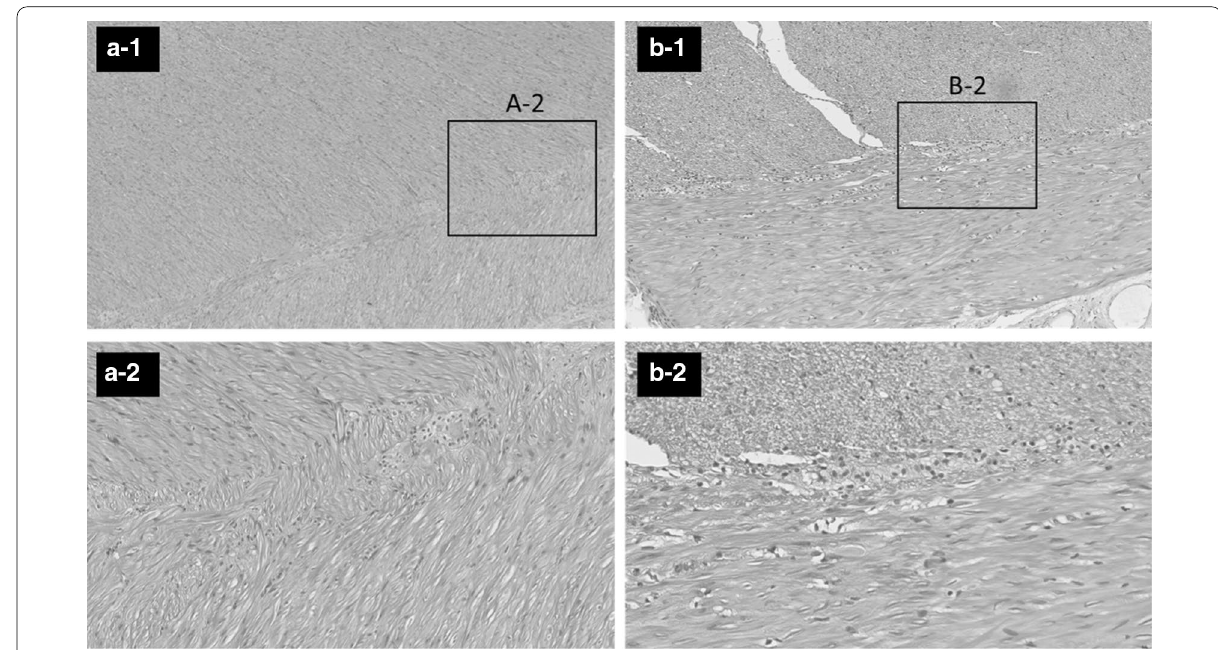
Fig. 6 Pathological findings. a The muscular layers of the dilated right-side colon (A-1) and its myenteric plexus (Auerbach’s plexus) (A-2, HE show no specific degeneration. b Both the longitudinal muscle and the circular muscle in the collapsed left-side colon are thickened, but no vacuolar degeneration is observed (B-1). No specific degeneration is observed in the myenteric plexus (Auerbach’s plexus) (B-2, HE